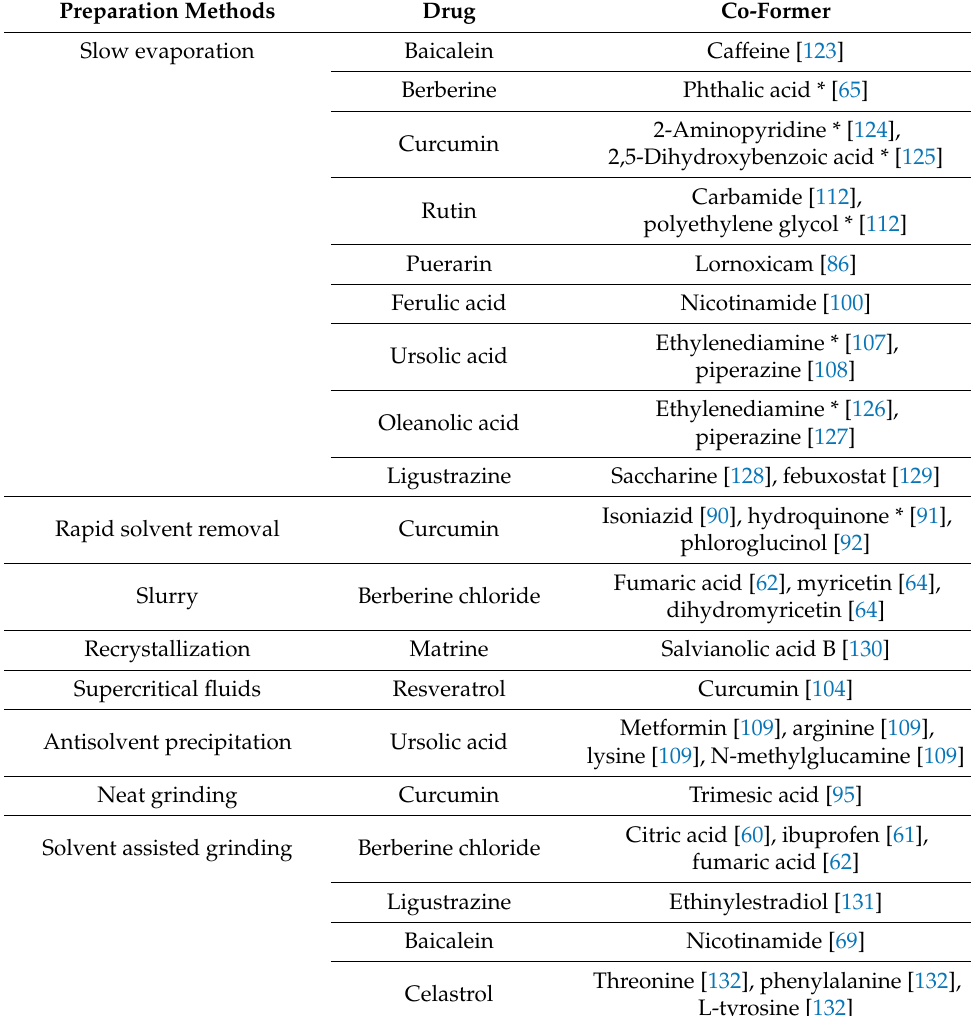
Table 4. The preparation methods of T-API